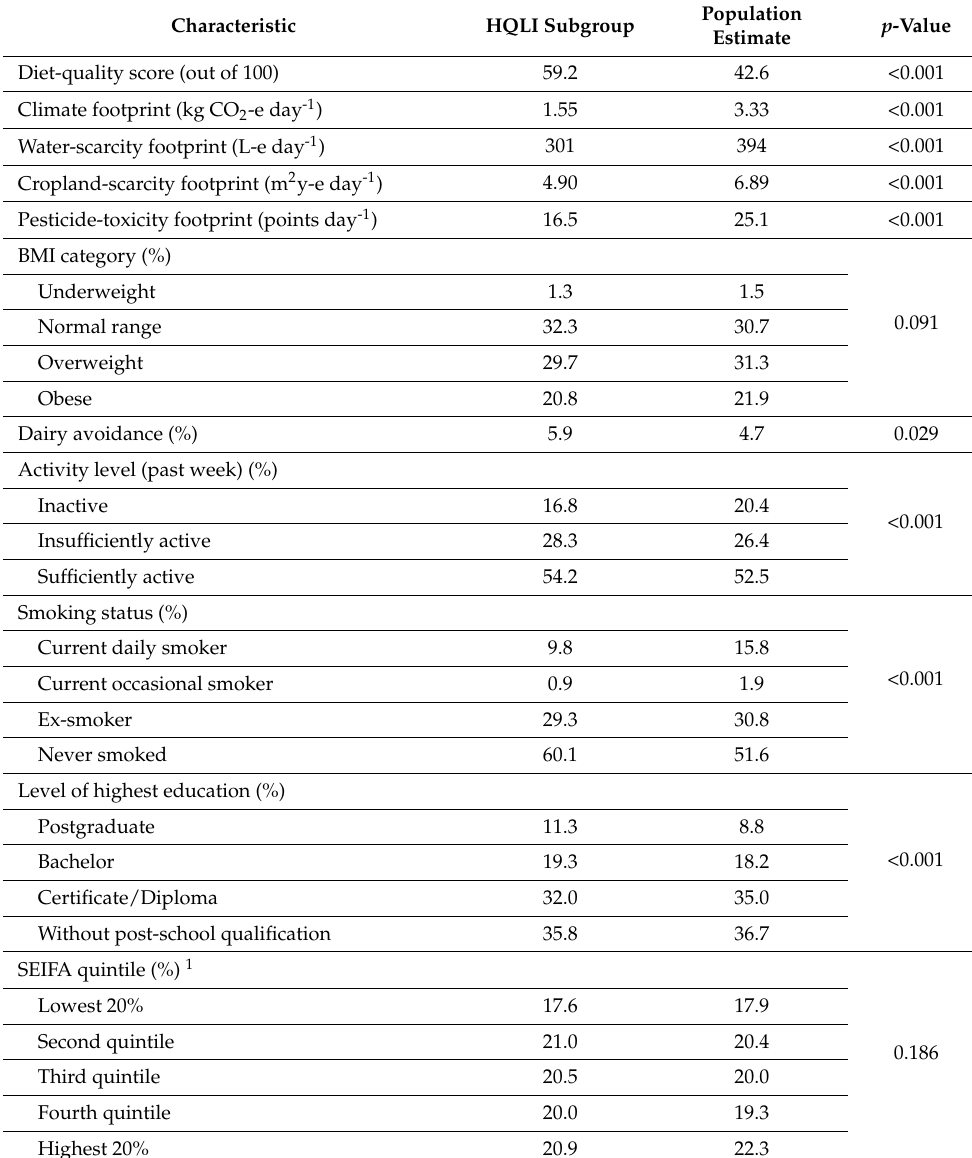
Table 1. Characteristics of the higher diet quality/lower environmental impact (HQLI) subgroup ( n = 1700) compared to the population estimate ( n =